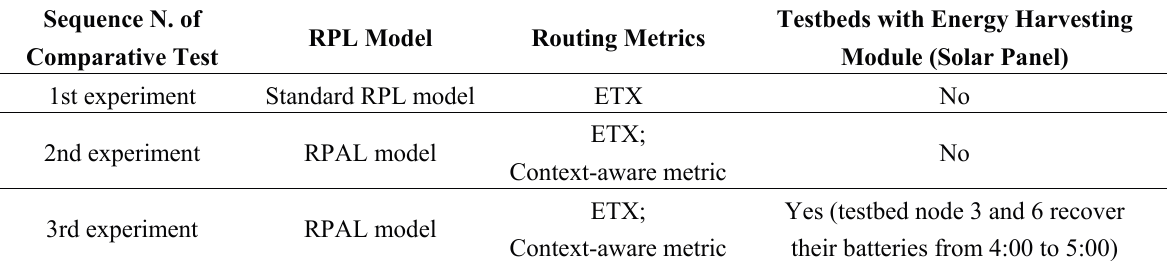
Table 12. Different settings in three comparative